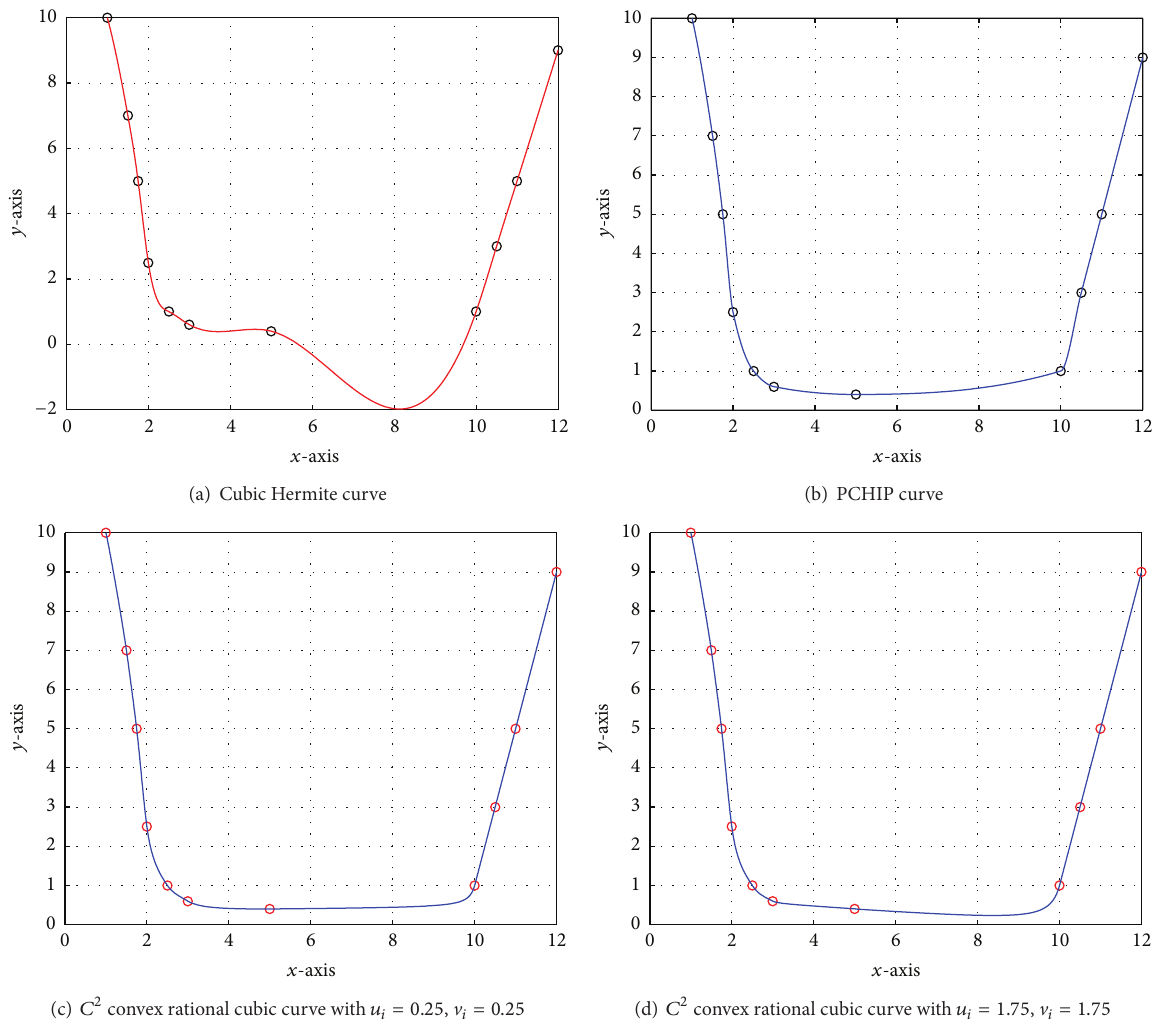
Figure 2: Comparison of convexity- and nonconvexity-preserving curves.